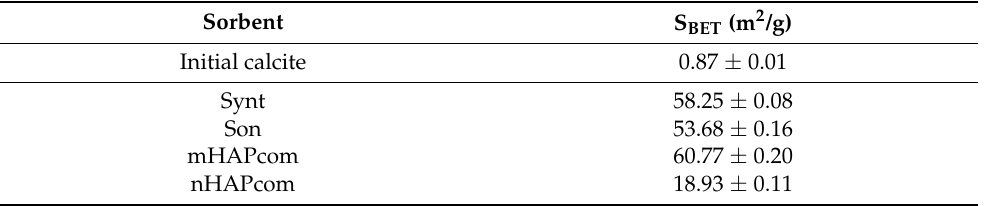
Table 1. Measured values of S BET surface areas for all studied